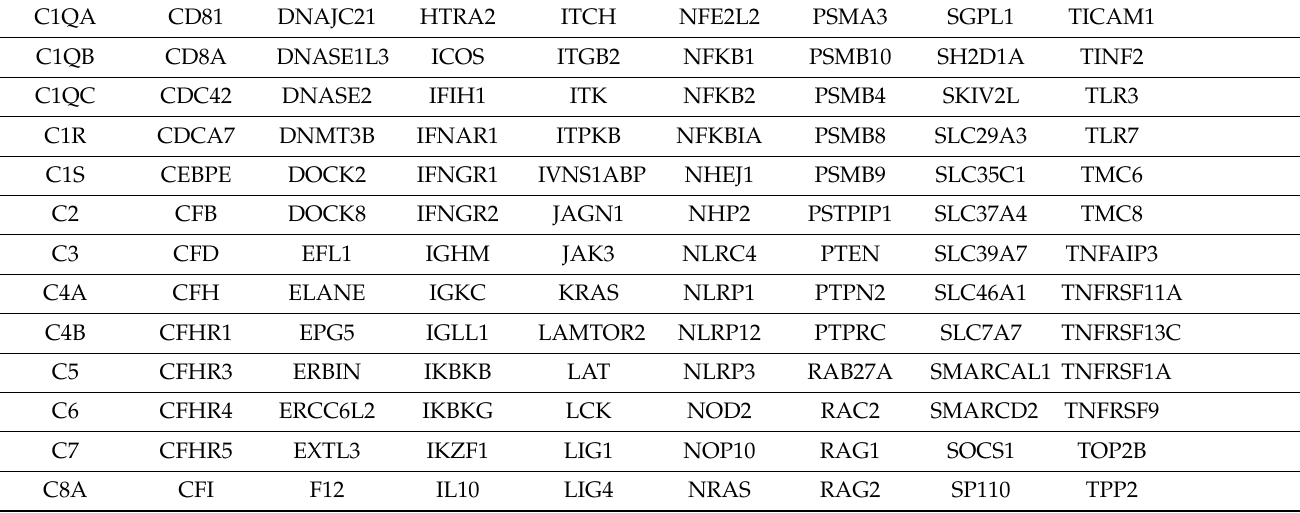
Table 4. Immunology exome sequencing of a panel of 356